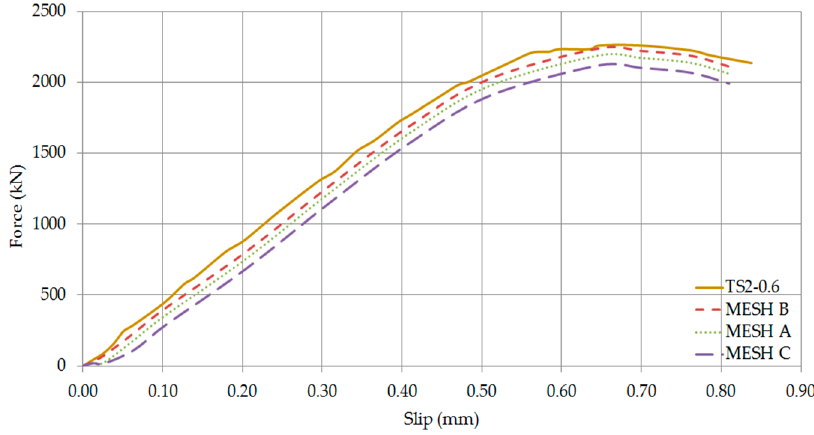
Figure 21. Axial force—Slip Curves of TS1-1.2 (Comparison of mesh densities).